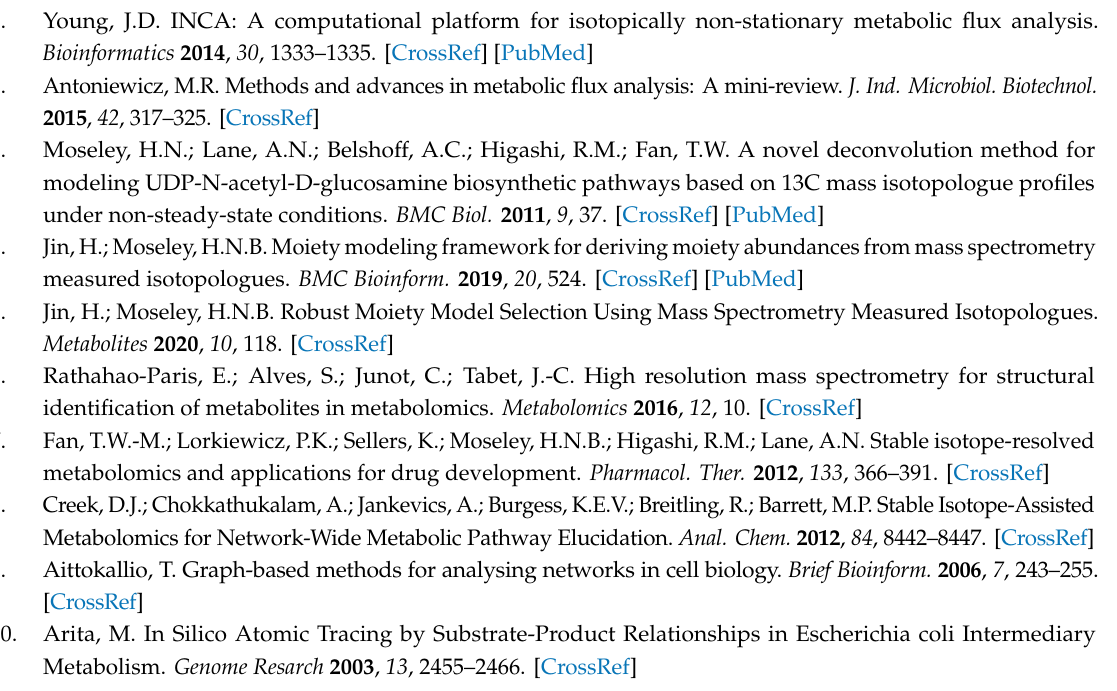
Figure S1: Derived coloring identifier, Figure S2: KEGG compound with S-containing aromatic ring, Figure S3: Representative compounds that cannot be distinguished by coloring identifier, Figure S4: KEGG Compound C00047, Table S1: Compounds with the same coloring identifiers, which includes R groups, Table S2: Generation of atom identifiers for compound C00047 via graph coloring method, Spreadsheet S1: All pairs detected by